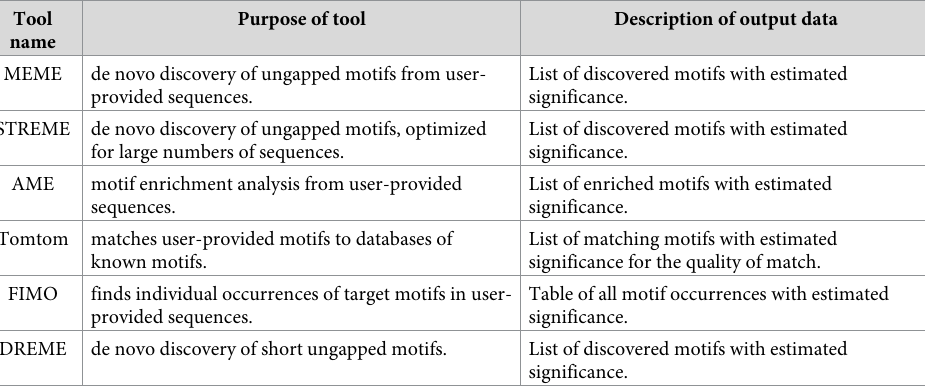
Table 1. A list of MEME Suite tools that are currently included in